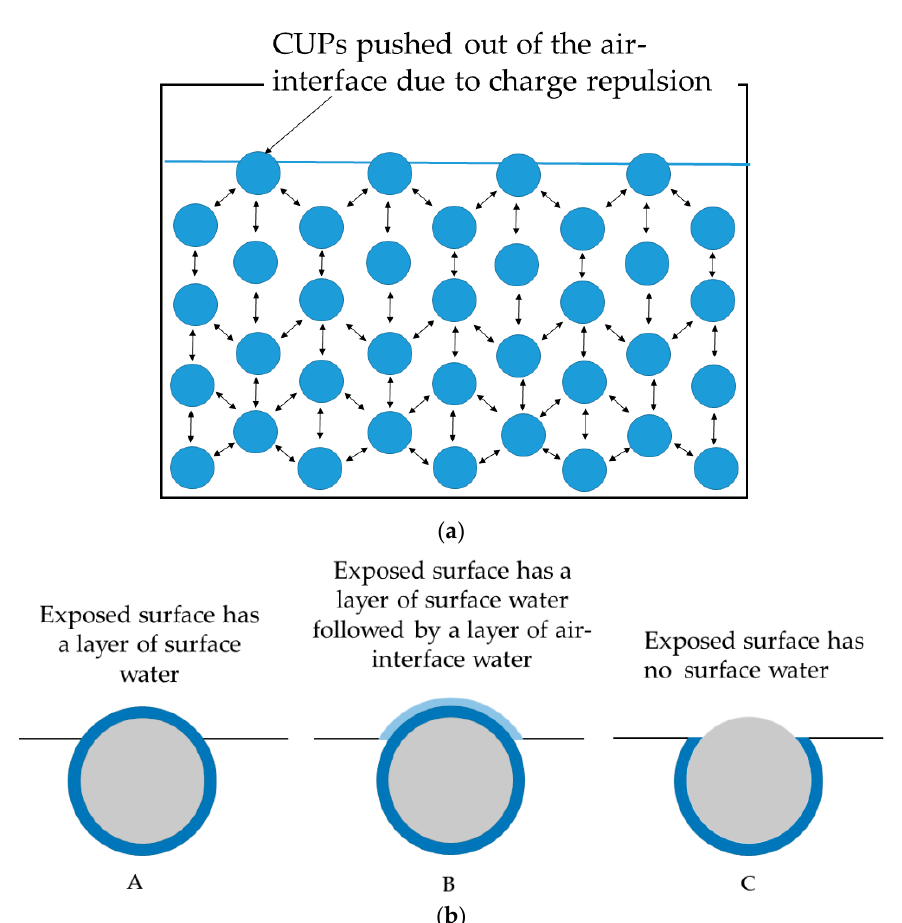
Figure 5. ( a ) CUP particles are pushed through the N 2 water interface due to charge repulsion from the particles below. ( b ) CUP particles that are pushed through the N 2 –water interface due to charge repulsion can exist in three possible states (A–C).